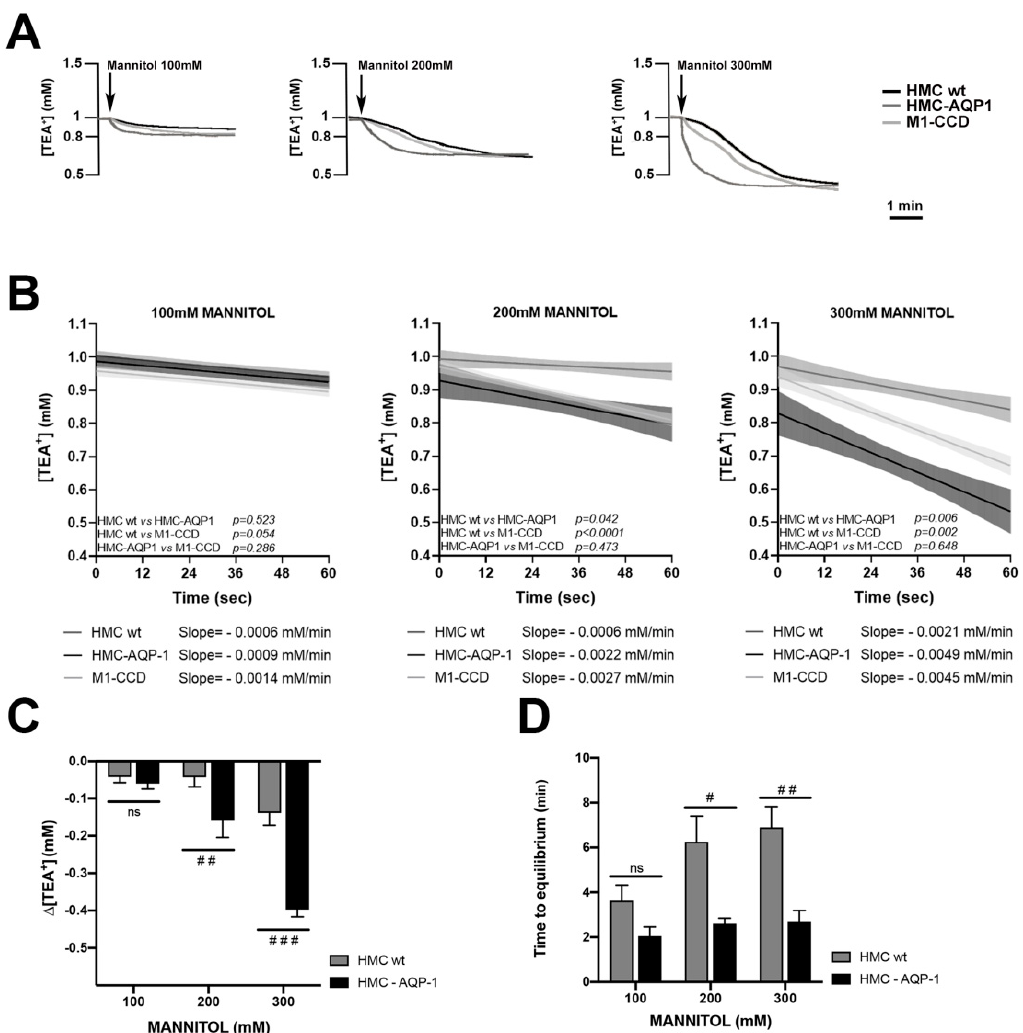
Figure 3. Osmotically induced transepithelial water transport in wt and AQP1-transfected HMC monolayers. ( A ) Repre- sentative traces of TEA + concentration drop in response to increasing doses of mannitol as recorded by TEA + sensitive microelectrodes; ( B ) Slopes (solid lines) and 95% confidence interval (shaded areas, CI) for the regression of [TEA + ] calcu- lated during the first 60s of the response. Statistical analysis of the differences between slopes is reported within each panel. The value of the slopes is reported on the bottom of each panel; ( C ) Changes of [TEA + ] ( Δ [TEA + ]) measured 1 min after application of mannitol in the apical bath; ( D ) Histogram representing the time required to reach maximal TEA + dilution following mannitol addition. Data are reported as mean values ± SEM. # p < 0.05; ## p < 0.01; ### p < 0.001; vs. HMC wt calculated by two-way analysis of variance (ANOVA) with Sidak’s multiple comparison test. (Mann 100mM: M1-CCD: n = 10; HMC wild type: n = 8; AQP1-transfected HMC: n = 4). (Mann 200mM: M1-CCD: n = 7; HMC wild type: n = 6; AQP1-transfected HMC: n = 5). (Mann 300mM: M1-CCD: n = 7; HMC wild type: n = 10; AQP1-transfected HMC: n =